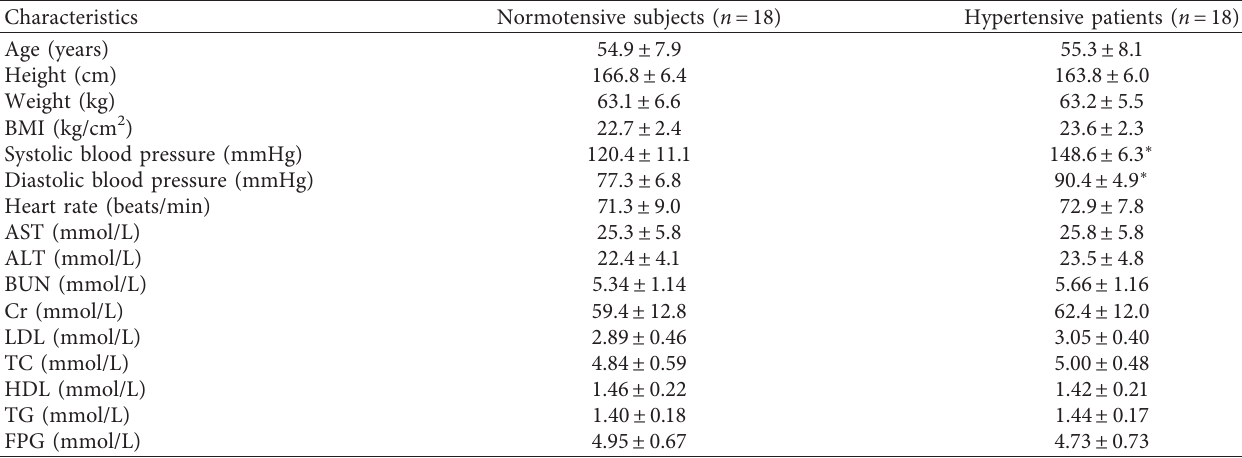
Table 1: Clinical and biochemical